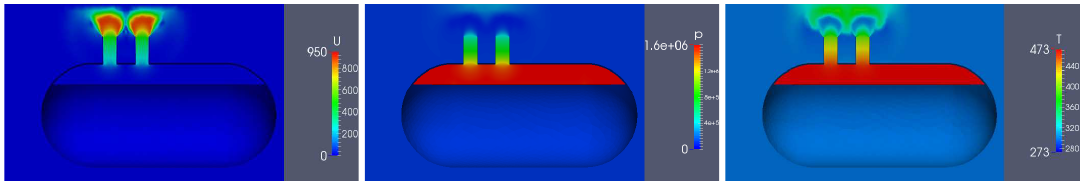
Figure 9. The velocity, pressure and temperature distribution in PRT and interior space at 0.0052 s.